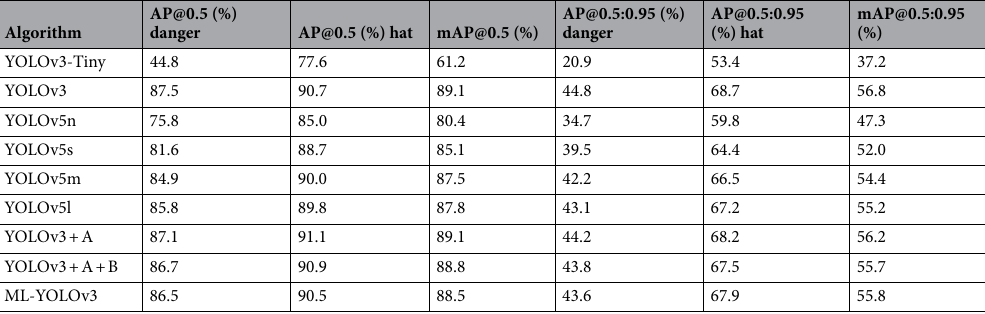
Table 5. Results of ablation experiments on AP and mAP. “@’’ indicates the IOU threshold